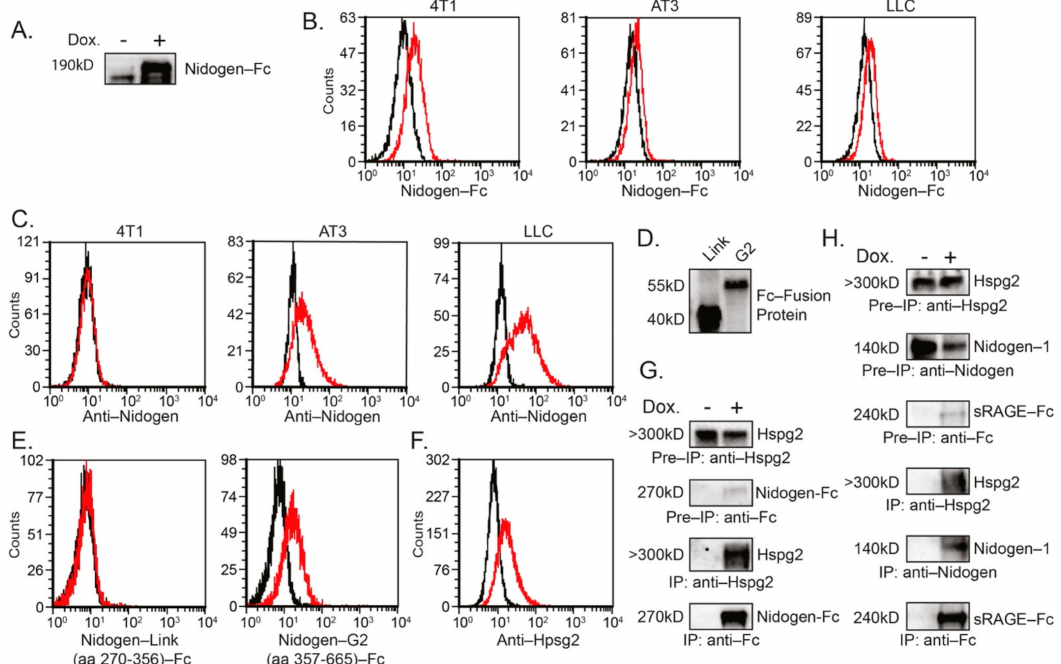
Figure 5. ( A ) Western blot analysis of Nidogen-Fc expression in supernatants of AT3 cells used for cell binding studies in ( B ). ( B ) Nidogen-1-Fc binding to tumor cells. The cells were incubated with supernatant containing Nidogen-1-Fc followed by incubation with APC-anti-Fc antibodies (red histograms). Black histograms represent cells incubated with control supernatant and APC-anti-Fc antibodies. ( C ) Staining of tumor cells with anti-Nidogen-1 antibodies followed by 2nd FITC-anti-rat antibodies (red histograms). Black histograms represent cells incubated with 2nd antibody only. ( D ) Western blot analysis of Nidogen link region (aa 270–356) fused to Fc and Nidogen G2 region (aa 357–665) fused to Fc. ( E ) Binding of Nidogen-G2 region-Fc fusion protein to AT3 cells. AT3 cells were incubated with supernatant containing either the Nidogen link region (aa 270–356) fused to Fc or Nidogen G2 region (aa 357–665) fused to Fc followed by incubation with APC-anti-Fc antibodies (red histograms). Black histograms represent cells incubated with control supernatant and APC-anti-Fc antibodies. ( F ) Staining of AT3 cells with anti-Hspg2 antibodies followed by 2nd FITC- anti-rat antibodies (red histograms). Black histograms represent cells incubated with 2nd antibody only. ( G ) Co-immunoprecipitation of endogenous Hspg2 in AT3 cells overexpressing tet-inducible Nidogen-1-Fc fusion protein. Induction of the Fc fusion protein was done by adding 1 µ g/mL doxycycline (Dox.) to the culture. Pre-IP = Cell extract samples prior to immunoprecipitation. IP = Immunoprecipitated samples. ( H ) Co-immunoprecipitation of endogenous Nidogen-1 and endogenous Hspg2 in LLC cells overexpressing tet-inducible sRAGE-Fc fusion protein. Induction of Fc fusion proteins was done by adding 1 µ g/mL doxycycline (Dox.) to the culture. Pre-IP = Cell extract samples prior to immunoprecipitation. IP = Immunoprecipitated